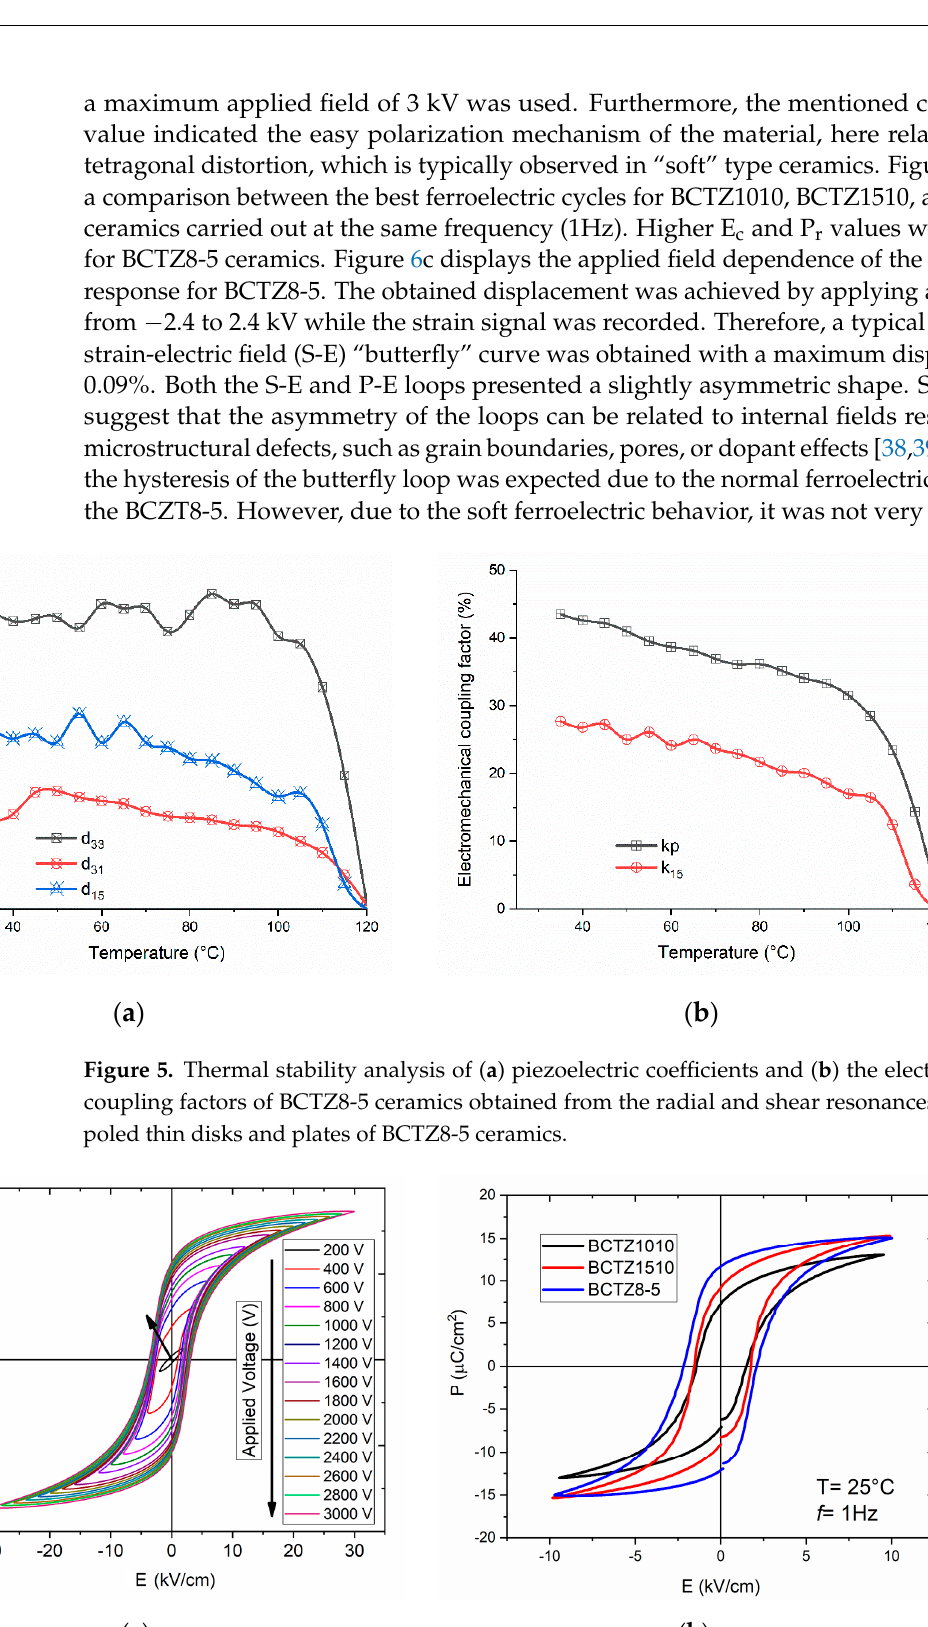
( c ) Figure 6. ( a ) Ferroelectric hysteresis loop at 1Hz of BCTZ8-5 ceramics for the maximum applied field of 30 kV/cm. ( b ) Ferroelectric loops at 1Hz for BCTZ8-5 ceramic in comparison with BCZT1510 and BCTZ1010 ceramics. ( c ) S-E loop for BCTZ8-5 ceramic. The ferroelectric fatigue study of the BCTZ8-5 sample, after the test in Figure 6a, was carried out by a triangular wave of 1 kHz frequency and 2400 V amplitude over a thick- ness of 1 mm, which is shown in Figure 7. Certain differences can be observed in Figure 7a with respect to Figure 6a. It is well-known that ferroelectric hysteresis cycles cause both reversible and irreversible domain wall movements and the results depend on the previ- ous history of the sample. Furthermore, some differences are expected as the frequency of the test is changed. Figure 7a,c compares the ferroelectric polarization and current hyste- resis loops at 1, 10 5 , and 10 7 cycles, respectively. Figure 7d describes three different changes of the remanent polarization. In Stage A, from the beginning until 10 3 cycles, P r was nearly constant, determining a domain switching stability at small cycle numbers. In Stage B, between 10 3 to 10 5 cycles showed a fast decrease of up to 89%. Finally, in Stage C, the P r dropped off slightly and slowly to 81% after 10 7 cycles applied by less speed. Table 2 lists the average of remanent polarization, coercive field, and current at 1, 10 5 , and 10 7 cycles. Ferroelectric properties degradation has been associated with intrinsic defects, re- distributions of imperfection after switching the dipole process, and punctual defects by doping [40]. Therefore, BCTZ8-5 showed a high electrical fatigue resistance, which makes it a promising candidate for actuator or nonvolatile random-access memory applications when prepared in thin film form [41].